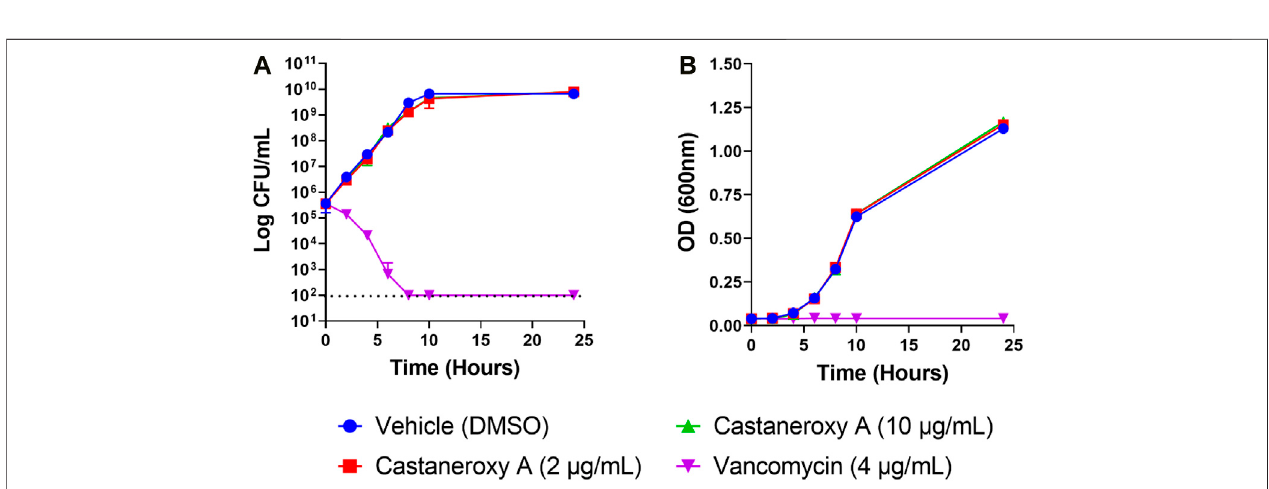
FIGURE7| EffectsofcastaneroxyA( 1 )on S.aureus growthandsurvival.Growthcurvesweredetermined of S.aureus strainLACtreatedwith 1 (2and10 μ g/mL), vehicle control (DMSO) and positive control (vancomycin, 4 μ g/mL). Exponential-phase MRSA LAC (AH1263) was diluted in CAMHB by optical density to reach a fi nal starting concentration of 5 × 10 5 CFU/mL; this was con fi rmed by colony counts. (A) Viability was enumerated at the indicated time points by serial dilution plating. The limit of detection was 100 CFU/mL (indicated with dashed line), and no growth was detected for vancomycin for the time points of 8, 10 and 24 h. (B) Optical density (600 nm)ofthecultures wasalsoassessed at eachtimepoint. Experiments included threetechnical replicatesand wererepeatedwithnewbiologicalreplicates, yielding the same results. Data presented here are from one experiment.